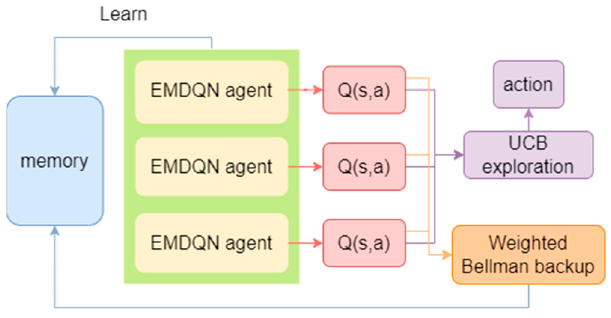
Figure 3. EMDQN Figure 3. EMDQN workflow.